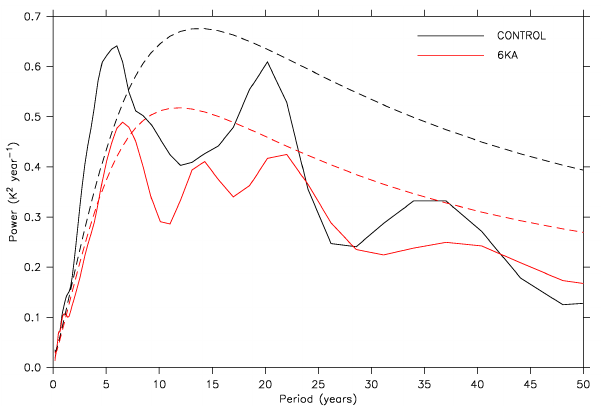
Fig. 6. The wavelet power spectrum of the monthly sea surface tem- perature anomaly in the Ni˜no 3.4 region (170–120 ◦ W, 5 ◦ S–5 ◦ N) for years 201–1200 of experiments CONTROL (solid black) and 6KA (solid red). Dashed lines show the 95% confidence level for a lag-one autoregressive process with the same variance and autocor- relation coefficient as the input